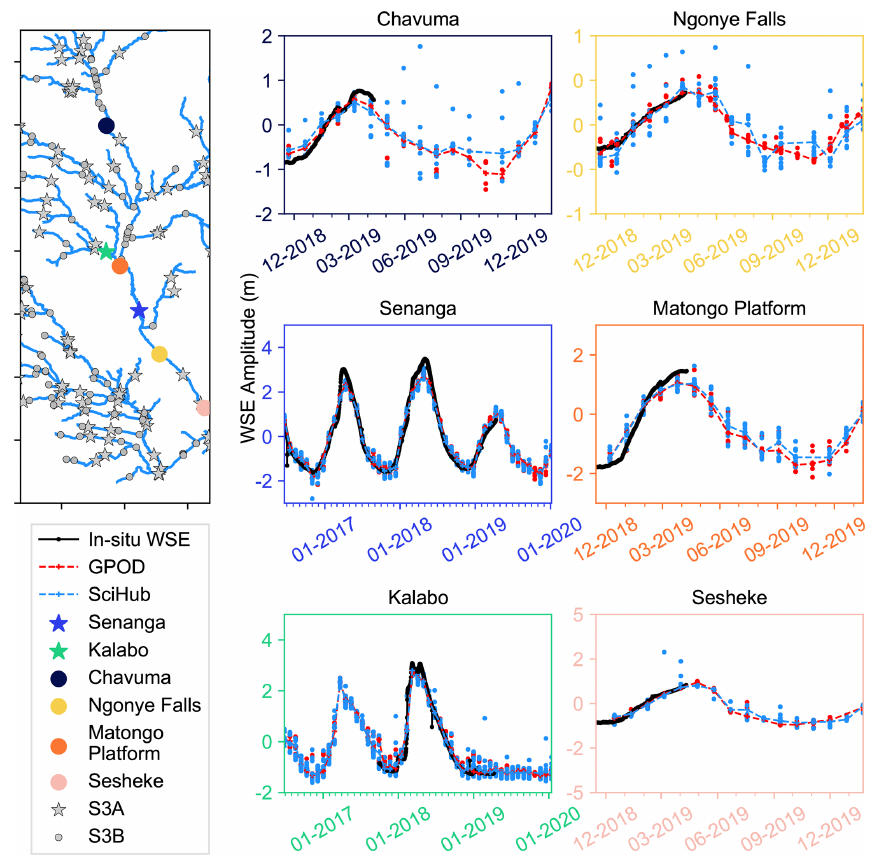
Figure 5. In situ and satellite water surface elevation (WSE) at six locations in the upper Zambezi basin (blue polygon in Fig. 3). The plot colors correspond to the marker colors for each station in the map. The lines indicate the along-track mean